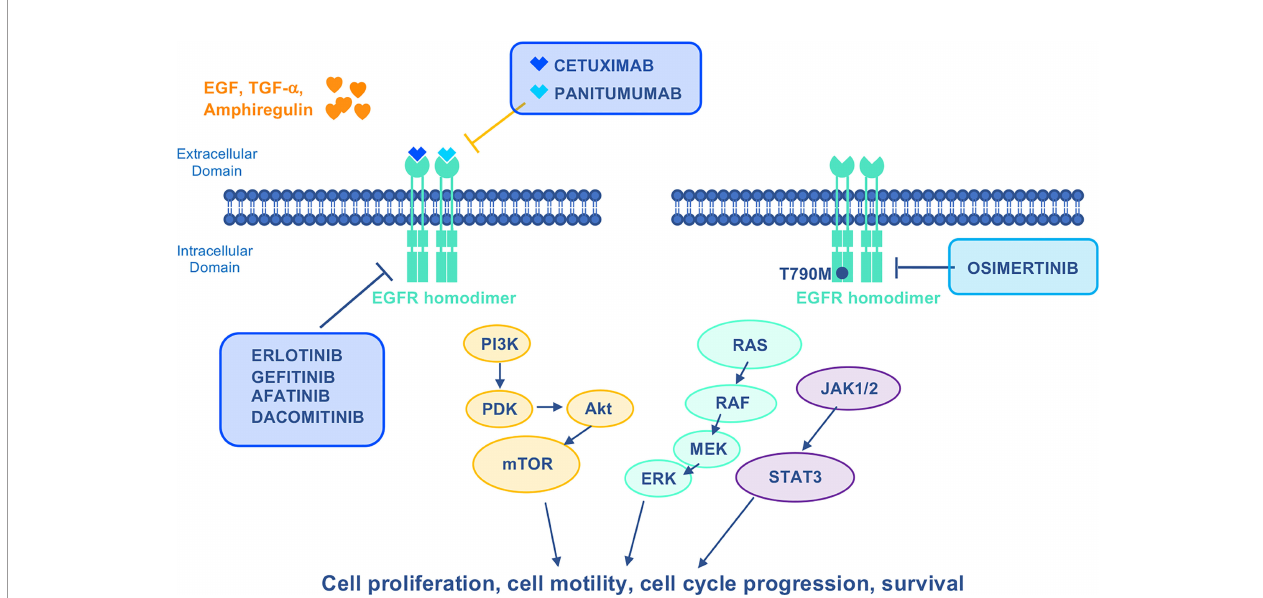
FIGURE 3 | Mechanism of action of EGFR – targeted drugs. EGFR activates Ras/Raf/MEK/ERK, PI3K/Akt/mTOR, and JACK1/2/STAT3 oncogenic signaling pathways to stimulate growth and proliferation. Cetuximab and Panitumumab are mAbs that speci fi cally inhibit EGFR. First – generation reversible (ge fi tinib and erlotinib) and second – generation irreversible (afatinib and dacomitinib) TKIs were developed to target mutant EGFR. The third generation irreversible TKI Osimertinib is highly selective for EGFR – activating mutations as well as the EGFR T790M mutation. EGF, epidermal growth factor; JACK1/2, janus kinases 1/2; STAT3, signal transducer and activator of transcription 3; TGF – a , transforming growth factor